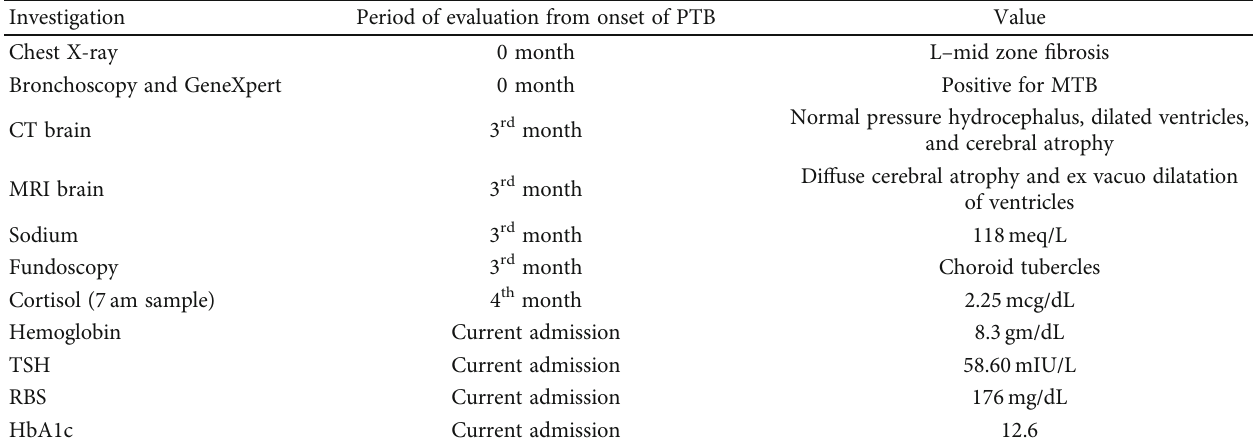
Table 1: Blood biochemistry and imaging fi